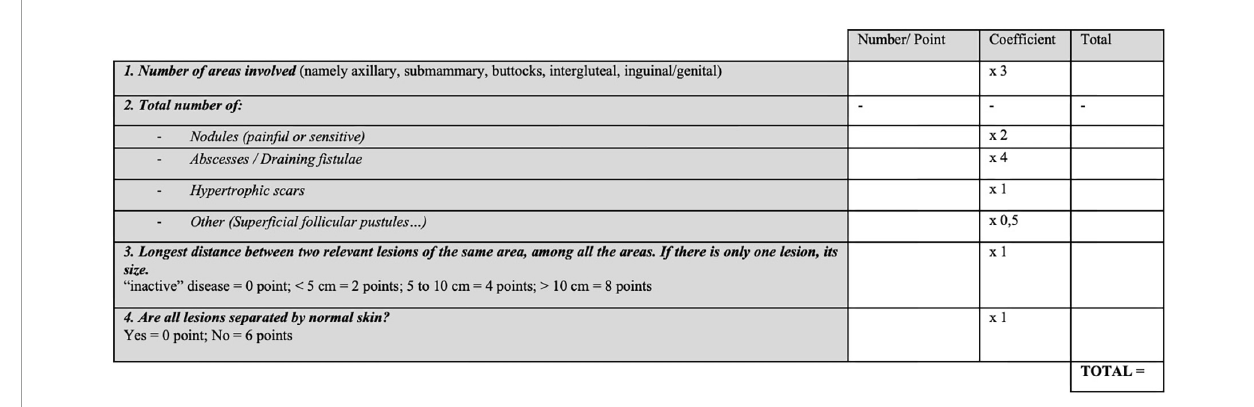
FIGURE2 Revuz-Modified Sartorius score 2007 (19).